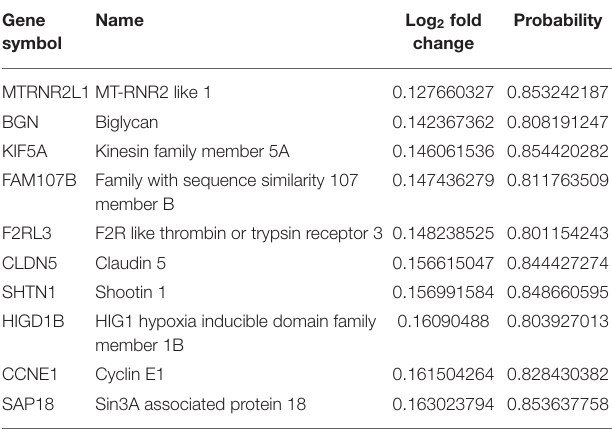
TABLE 1 | The top 10 upregulated genes in symAD vs. control samples.